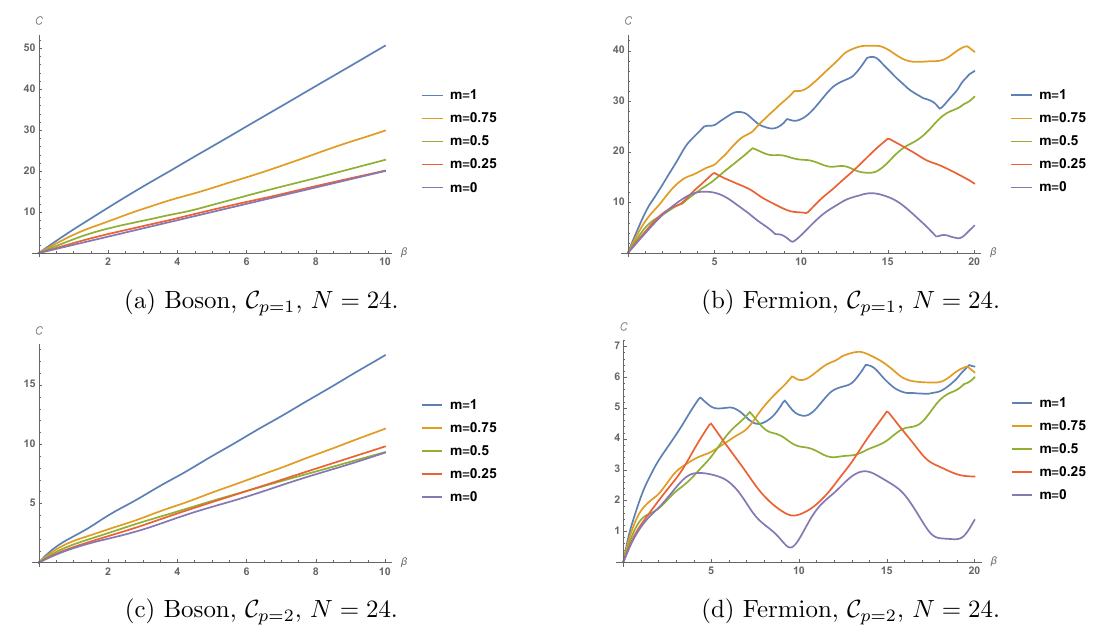
Figure 7. The complexity for bosonic and fermionic gaussian states with p = 1 and p = 2 norms. (a) and (c) represent the bosonic case while (b) and (d) represent the fermionic case. The cuto(cid:11) is chosen to be N = 24 and the ratio varies from 0 to 1 with an interval of 0 :